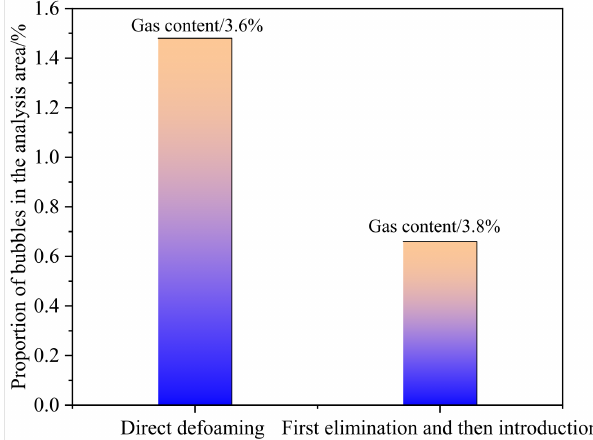
Figure 19. Air void control method: proportion of bubbles in the analysis